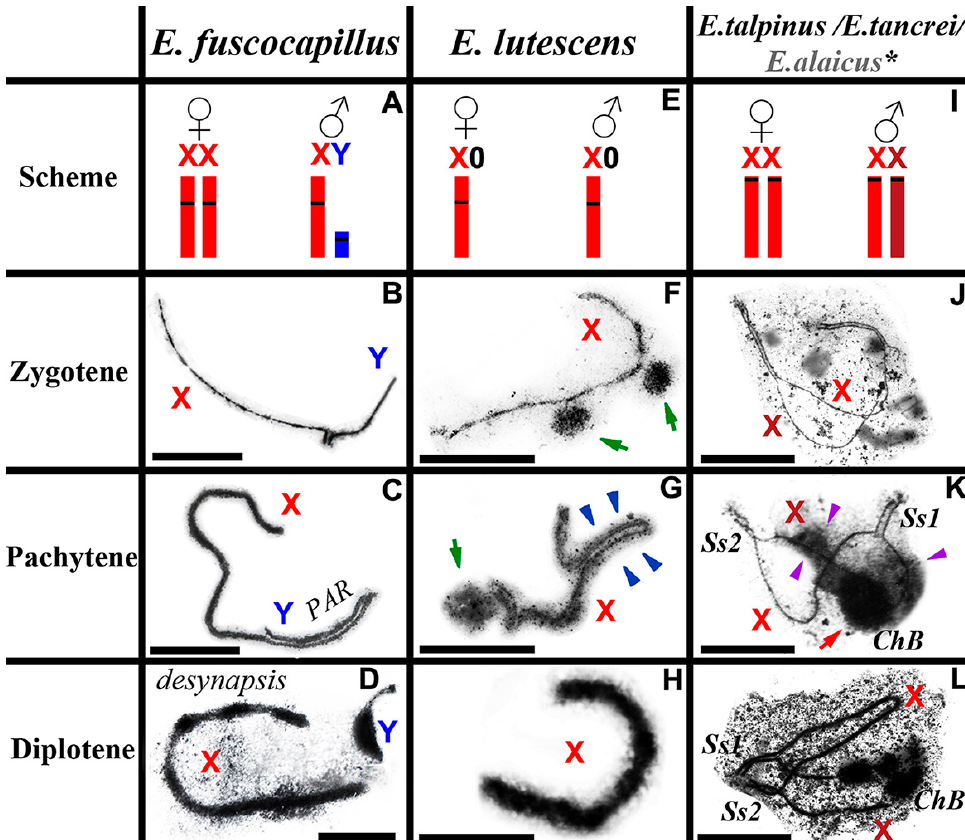
Figure 2. Ellobius male sex chromosomes behaviour in meiotic prophase I. Electron microscopy